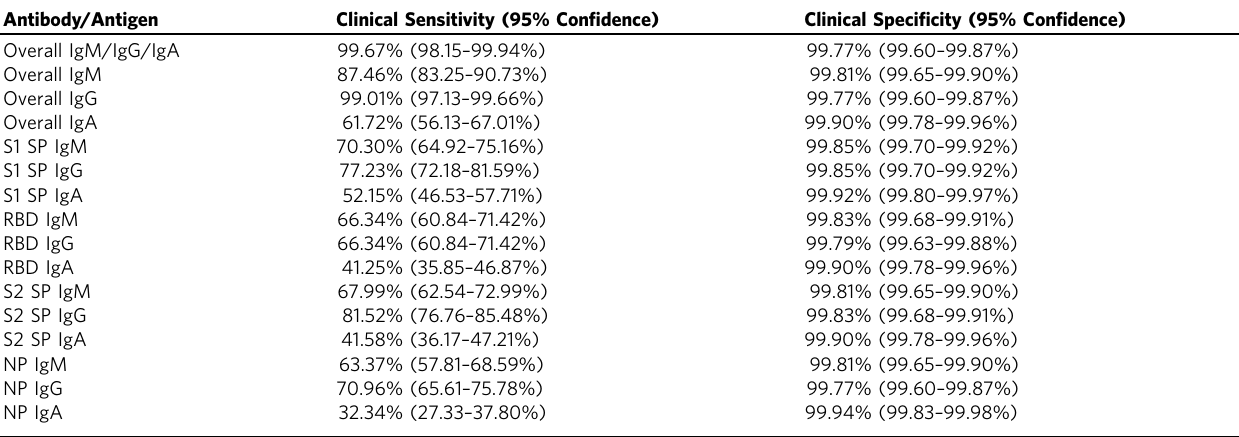
Serum samplesfrom RT-PCR con fi rmed COVID-19-positive ( n = 303) and COVID-19-negative ( n = 296) patients, along withhealthy controls ( n = 4,502)and non-COVID-19disease controls ( n = 128) collected prior to the COVID-19 outbreak, were analyzed by the Vibrant America Clinical Labs chemiluminescent immunoassay. Clinical sensitivity and speci fi city are displayed for IgM, IgG, and IgA antibodies against SARS-CoV-2spike 1 glycoprotein (S1 SP), spike 2 glycoprotein (S2 SP), receptor-binding domain (RBD), and nucleoprotein (NP). Clinical sensitivity and speci fi city for overall IgM, IgG, IgA, and for overall IgM/IgG/IgA are alsodisplayed. Data are presented as% (95% con fi dence levels). A more comprehensiveanalysis of the sensitivity and speci fi city of the Vibrant chemiluminescent immunoassay for SARS-CoV-2 has recently been published 26